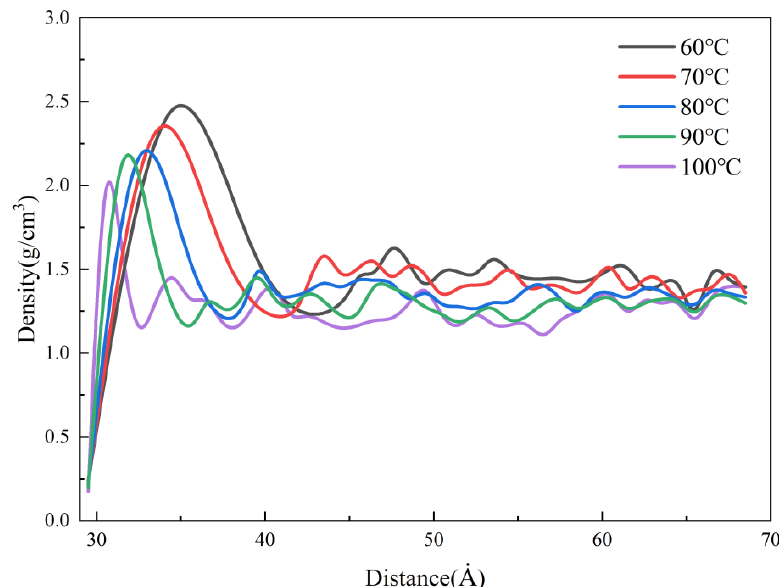
Figure 9. Density distributions at different mold temperatures along the flow direction.